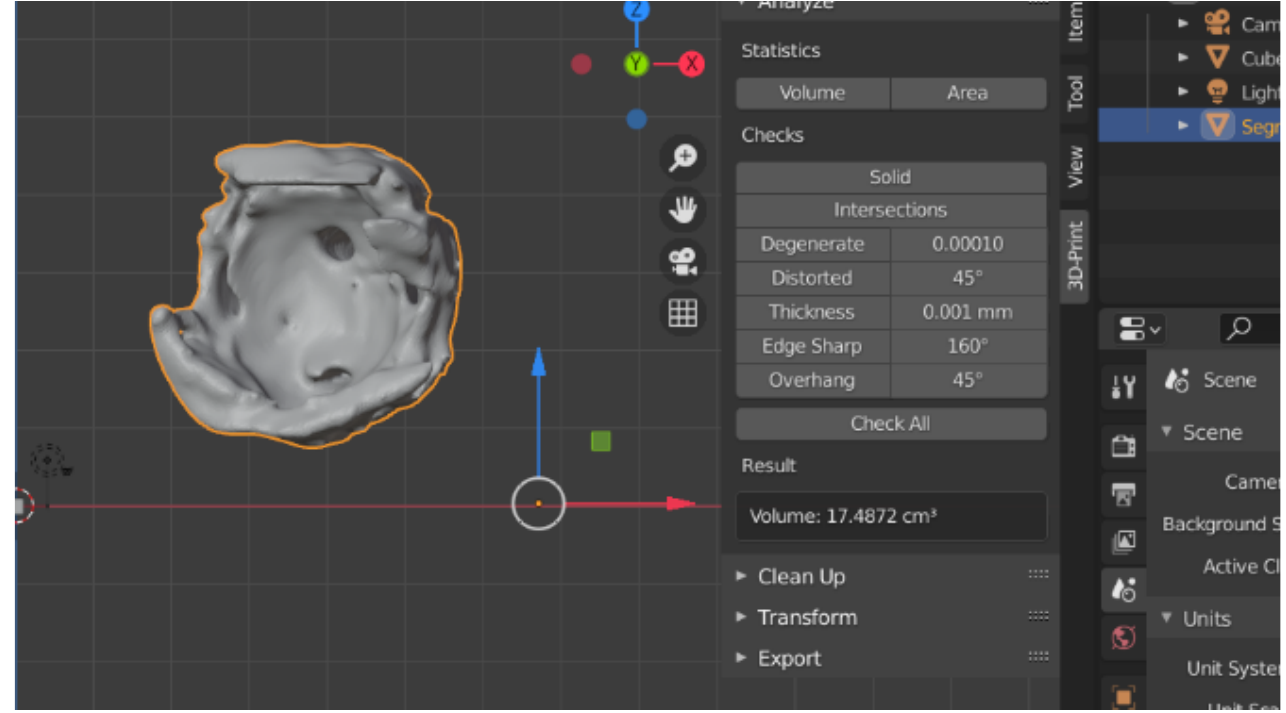
Figure 5. The volume of fat tissue in cm 3 .